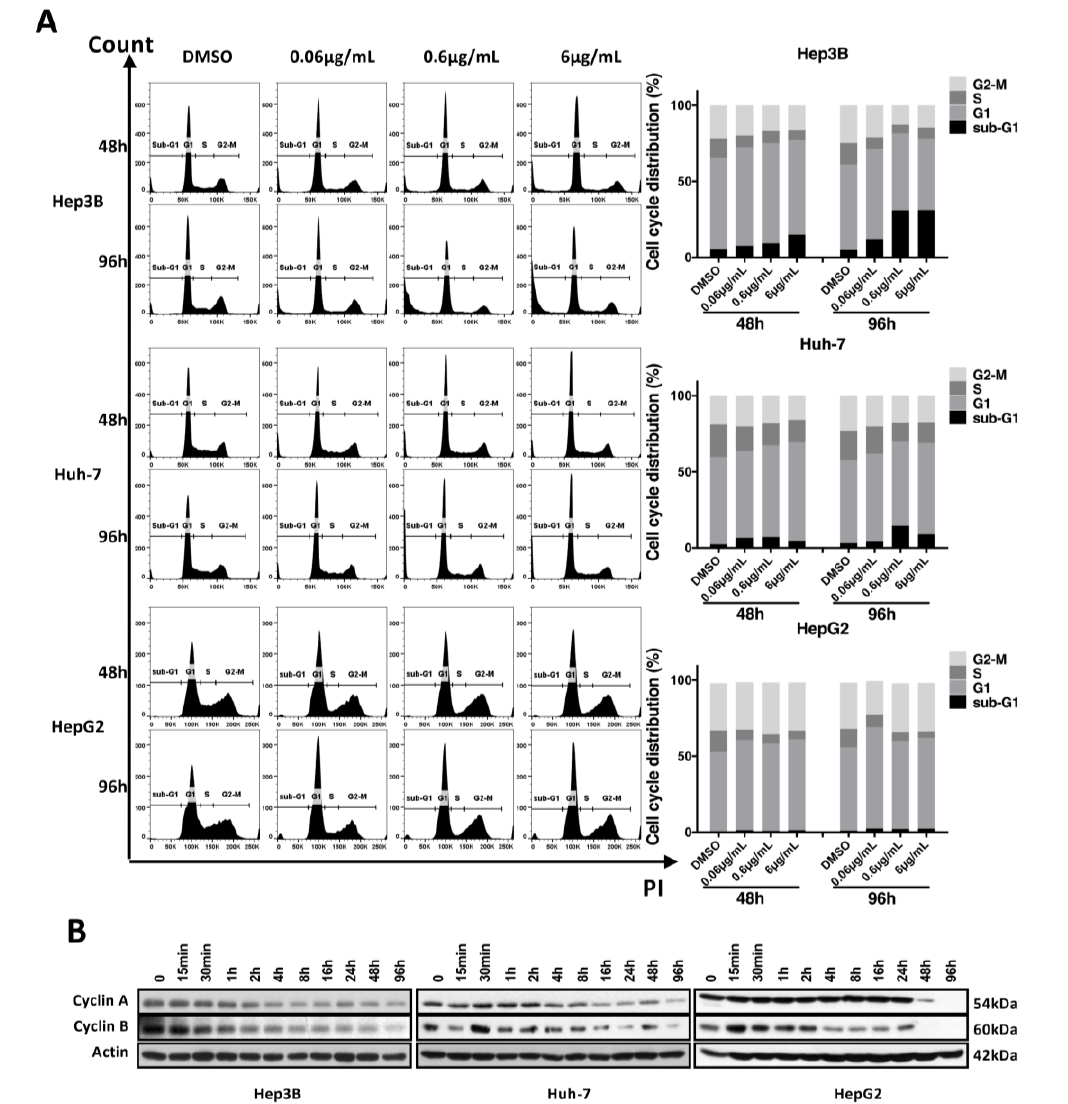
Figure 4. Haprolid treatment inhibits G1/S transition and induces cell cycle arrest in HCC cells. ( A ) HCC cells were treated with vehicle (DMSO) or increasing concentrations of haprolid for 48 and 96 h, fixed and stained with propidium iodide (PI) and subjected to flow cytometric analysis. Representative cell cycle histograms are presented (left panel). Cell cycle distribution in various phases is determined and shown (right panel). ( B ) Cyclin A and B expression levels were measured by Western blotting. Images representative of at least three independent experiments are shown.